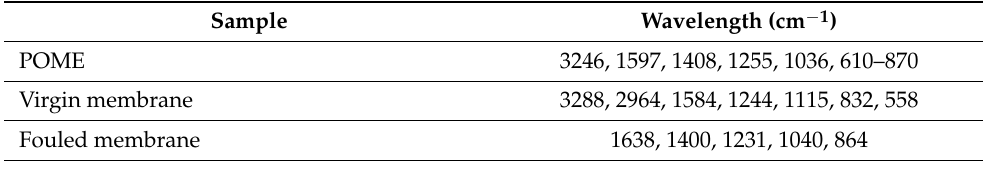
Table 3. Summary of FTIR spectra peak assigned for the samples.